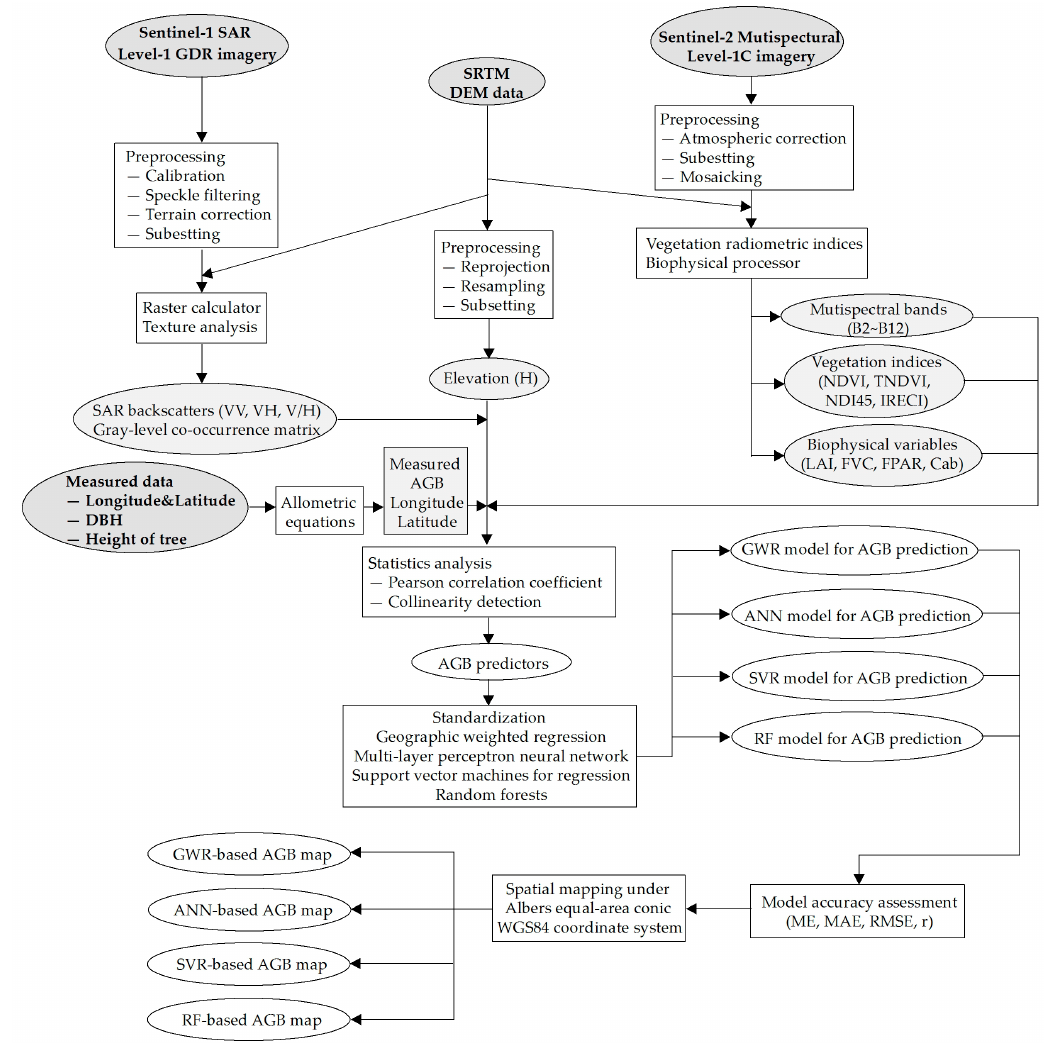
Figure 2. Flowchart of steps used for forest above-ground biomass mapping using Sentinel SAR and multispectral imagery. DBH is the abbreviation of diameter at breast height.